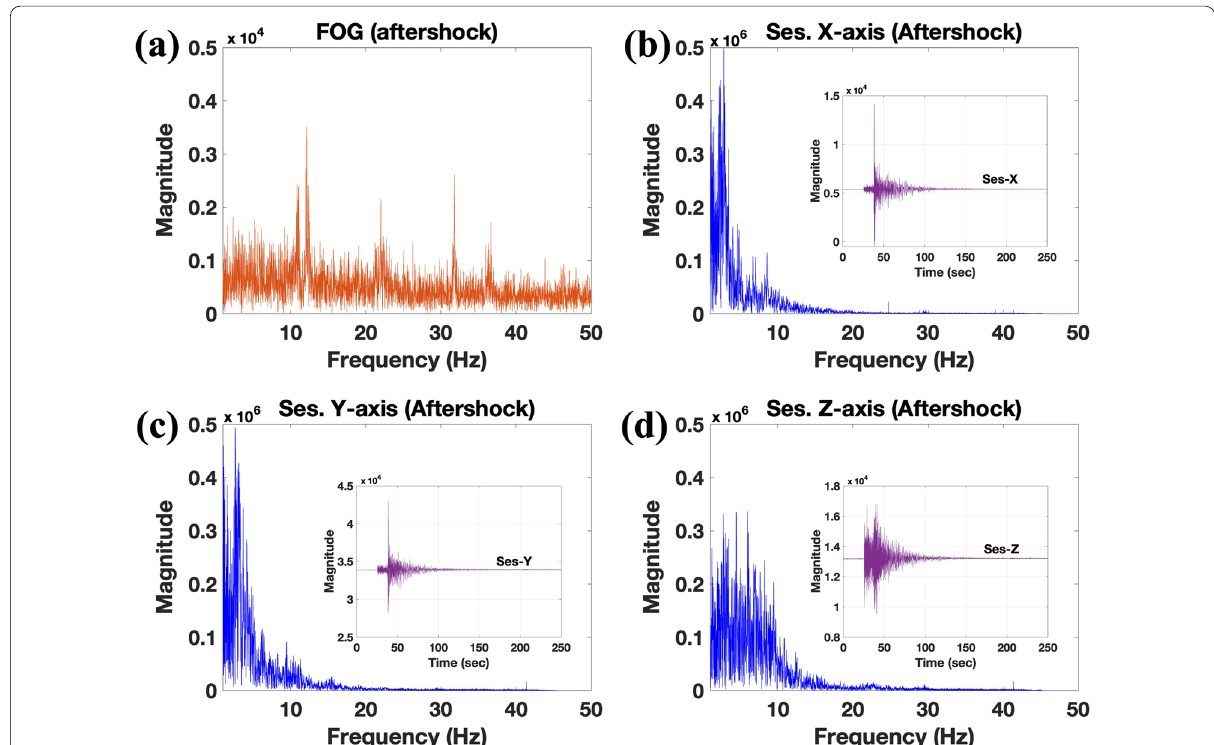
Fig. 4 Fast Fourier transform of the recorded aftershock data from a NCU‑FOG and b – d seismograph (SMART 24A) in X‑axis, Y‑axis, and Z‑axis, respectively. The insets of b – d are the corresponding raw data recorded by the seismograph